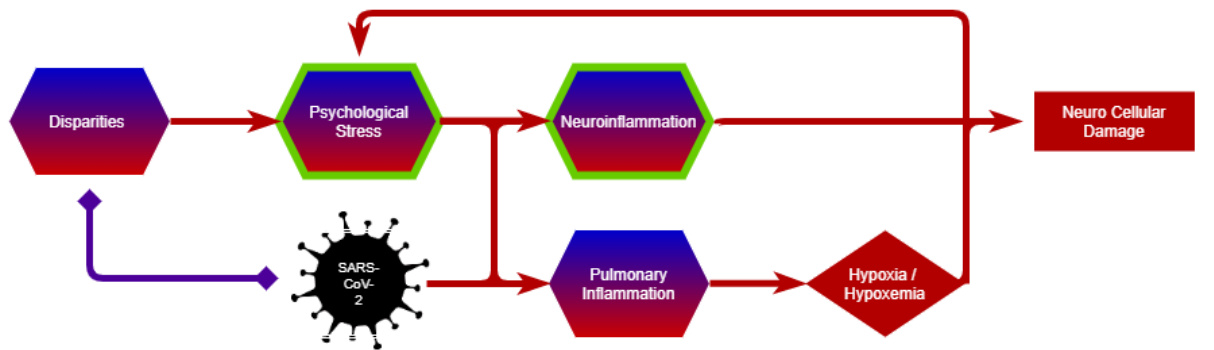
Figure 2. Disparities and sub-pathways to neuro and pulmonary outcomes. The figure illustrates how disparities may instigate psychological stress, leading to both neuroinflammatory and pulmonary inflammation. Pulmonary events can, in turn, lead to hypoxia and additional neurological events. The figure serves as an example of how a multiscale pathway perspective might be presented while concurrently developing the graphical and computational tools that will allow for the representation and analysis of these events and factors across